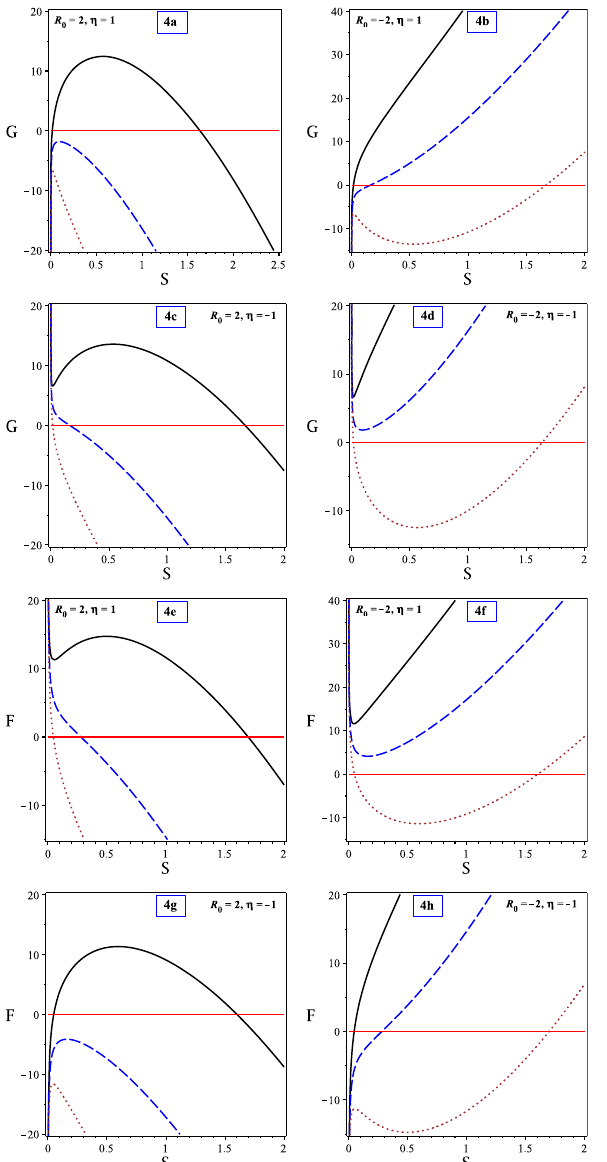
Fig. 4 G (and F ) versus S for Q = 0 . 02, and f R = 0 . 1. Also, k = 1 (continuous line), k = 0 (dashed line), and k = − 1 (dotted line)